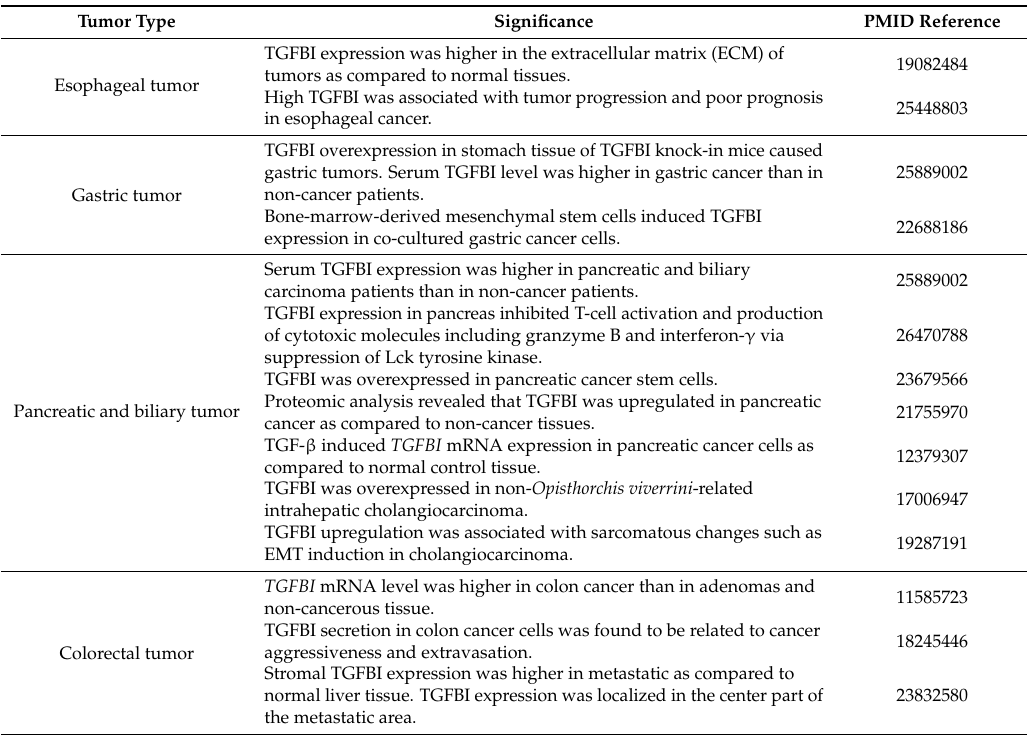
Table 1. Significance of TGFBI expression in gastrointestinal tumors.